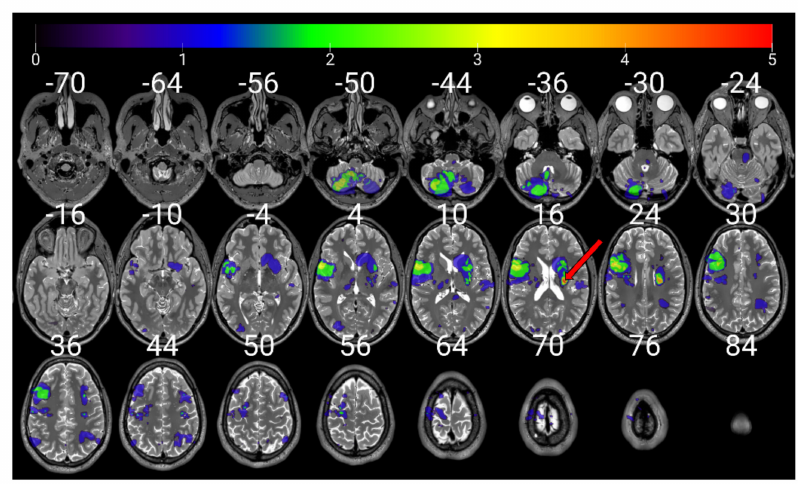
Figure 4. Superposition of the individual MRI lesion masks. Mosaic display of axial slices presented in neurological convention (left hemisphere on the left). The red arrow is pointing at the only cluster where at least 5 patient’s lesions overlapped. The color bar symbolizes the number of patients’ lesions overlapping from 0 to